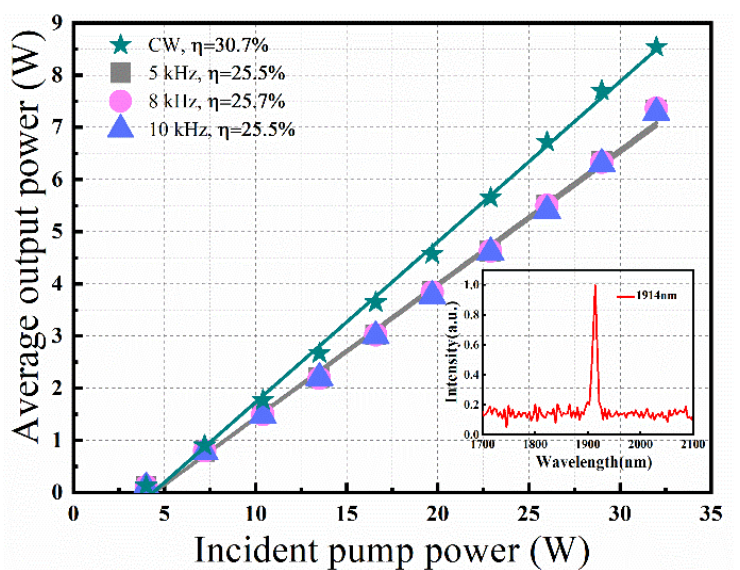
Figure 2. The average output power of diode-pumped CW and AO Q-switched Tm:YLF laser. Inset: output spectrum.